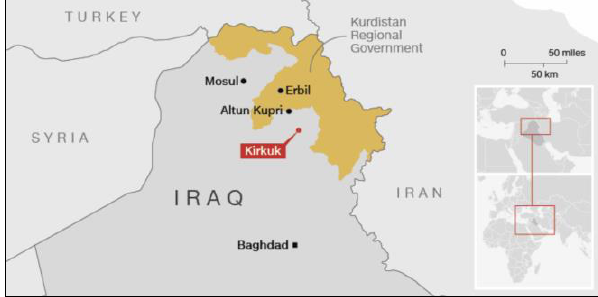
Figure 2. Northern Iraq (Kurdistan region of Iraq). URL 2 The following data will give some indicators about the region, as seen in table’ 3 ‘; Table 3. General information about Northern Iraq. (Ministry of Planning, 2011)